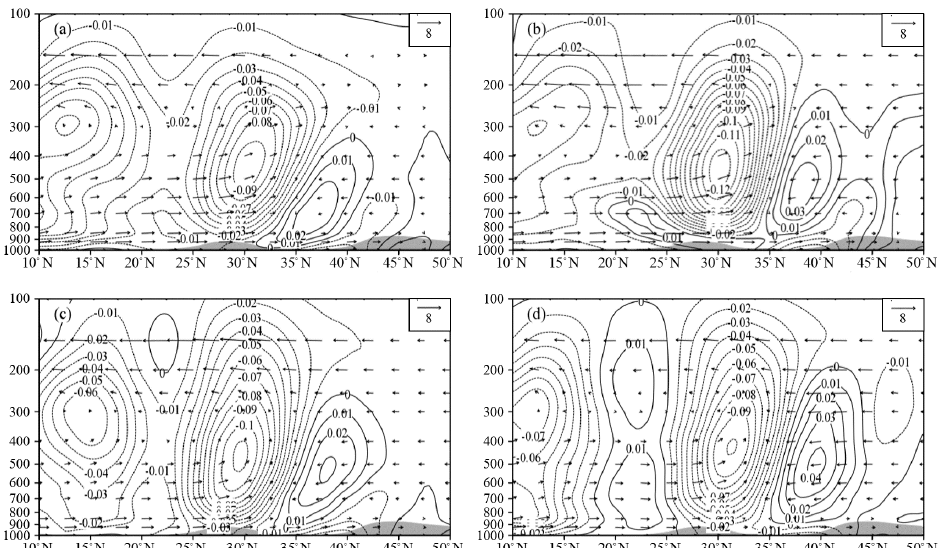
Figure 8. Profile along the mean 116~122 ◦ E of vertical velocity field (solid line, unit: m · s − 1 ) and wind field (vector, unit: s − 1 , the vertical velocity is magnified 10 times); the shaded areas denote the topography of years of early Meiyu arrival in the 1990s ( a ), late Meiyu arrival in the 1990s ( b ), early Meiyu arrival in the 2010s ( c ), and late Meiyu arrival in the 2010s ( d ).